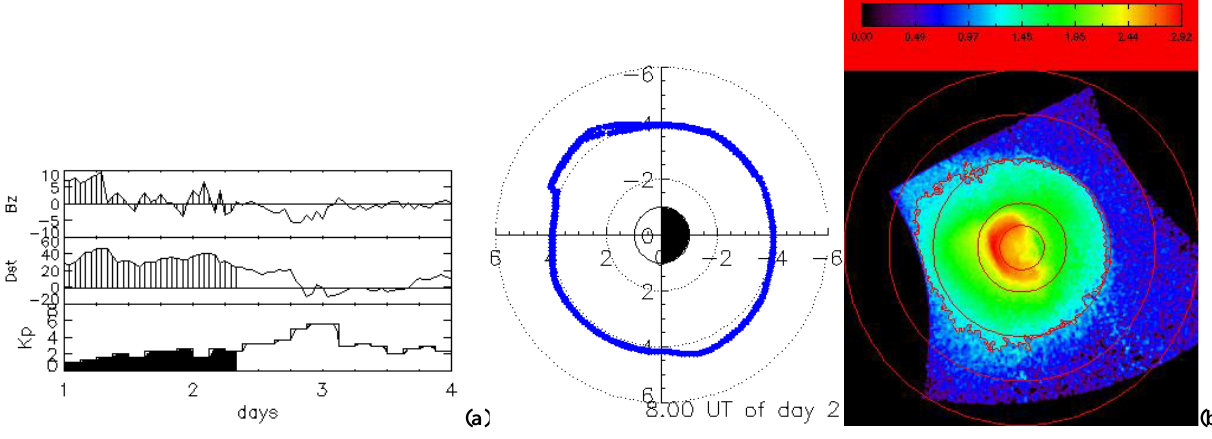
Figure 1: Left panel (a): result of the simulation based on the instability mechanism, the E5D model and the value of Kp on 9 June 2001, 8h00. The plasmapause in the geomagnetic equatorial plane corresponds to the blue line. The indexes Bz, Dst and Kp observed during the previous and following days are also displayed. The dotted circles correspond to L = 1, 2, 4 and 6 . Right panel (b): EUV observations on 9 June 2001 at 8h05, projected in the geomagnetic equatorial plane. The red line corresponds to 40% of the maximum intensity of the image and permits to visualize the plasmapause. The red circles correspond to L=1, 2, 4, 6 and 8.